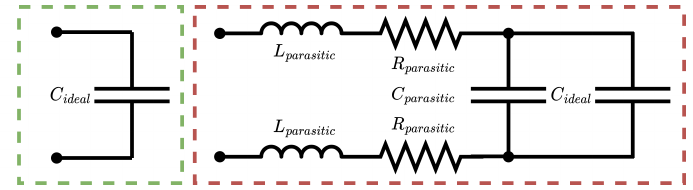
Figure 5. An ideal capacitor ( left ) and a real capacitor ( right ).